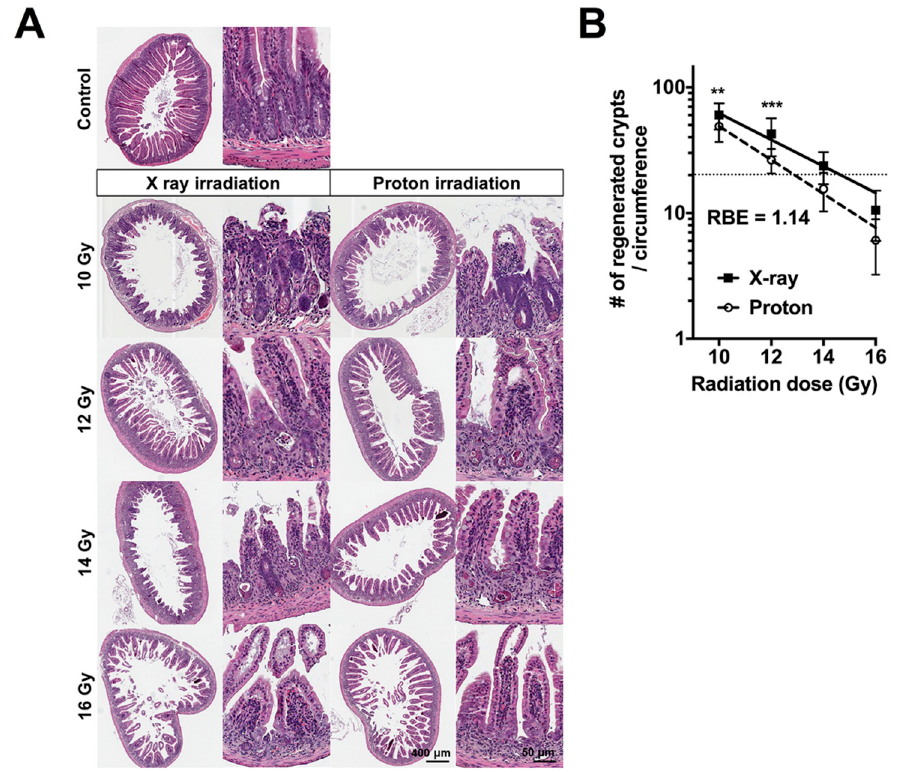
Figure 1. Proton irradiation is more effective in suppressing crypt survival in the mouse jejunum than X-ray irradiation: ( A ) The crypt microcolony assay showed a dose-dependent reduction of the regenerated crypts in X-ray- or proton-irradiated mouse jejunum sections. The abdomens of the anesthetized mice were irradiated with the indicated doses of X-rays or protons. Herein, the representative images of Hematoxylin and Eosin (H&E)-stained transverse sections of jejunum collected at 3.5 days postirradiation are shown. Unirradiated jejunum sections were presented as a control. ( B ) The radiation-dose response curves of mouse jejunum crypts: The data were presented as the mean ± standard deviation of the two independent experiments ( n = 13). The differences were evaluated by a two-way ANOVA, followed by a Bonferroni posttest; ** p < 0.01; *** p < 0.001. The relative biological effectiveness (RBE) was defined as the ratio of X-ray dose to proton dose corresponding to 20 regenerated crypts per circumference (dashed line).